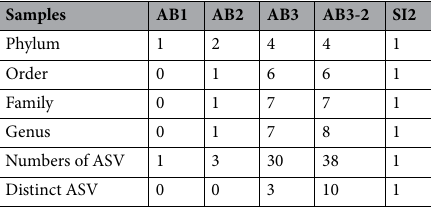
Table 3. Comparison of number of identified archaea taxa obtained from palm oil mill effluents (POME) samples.